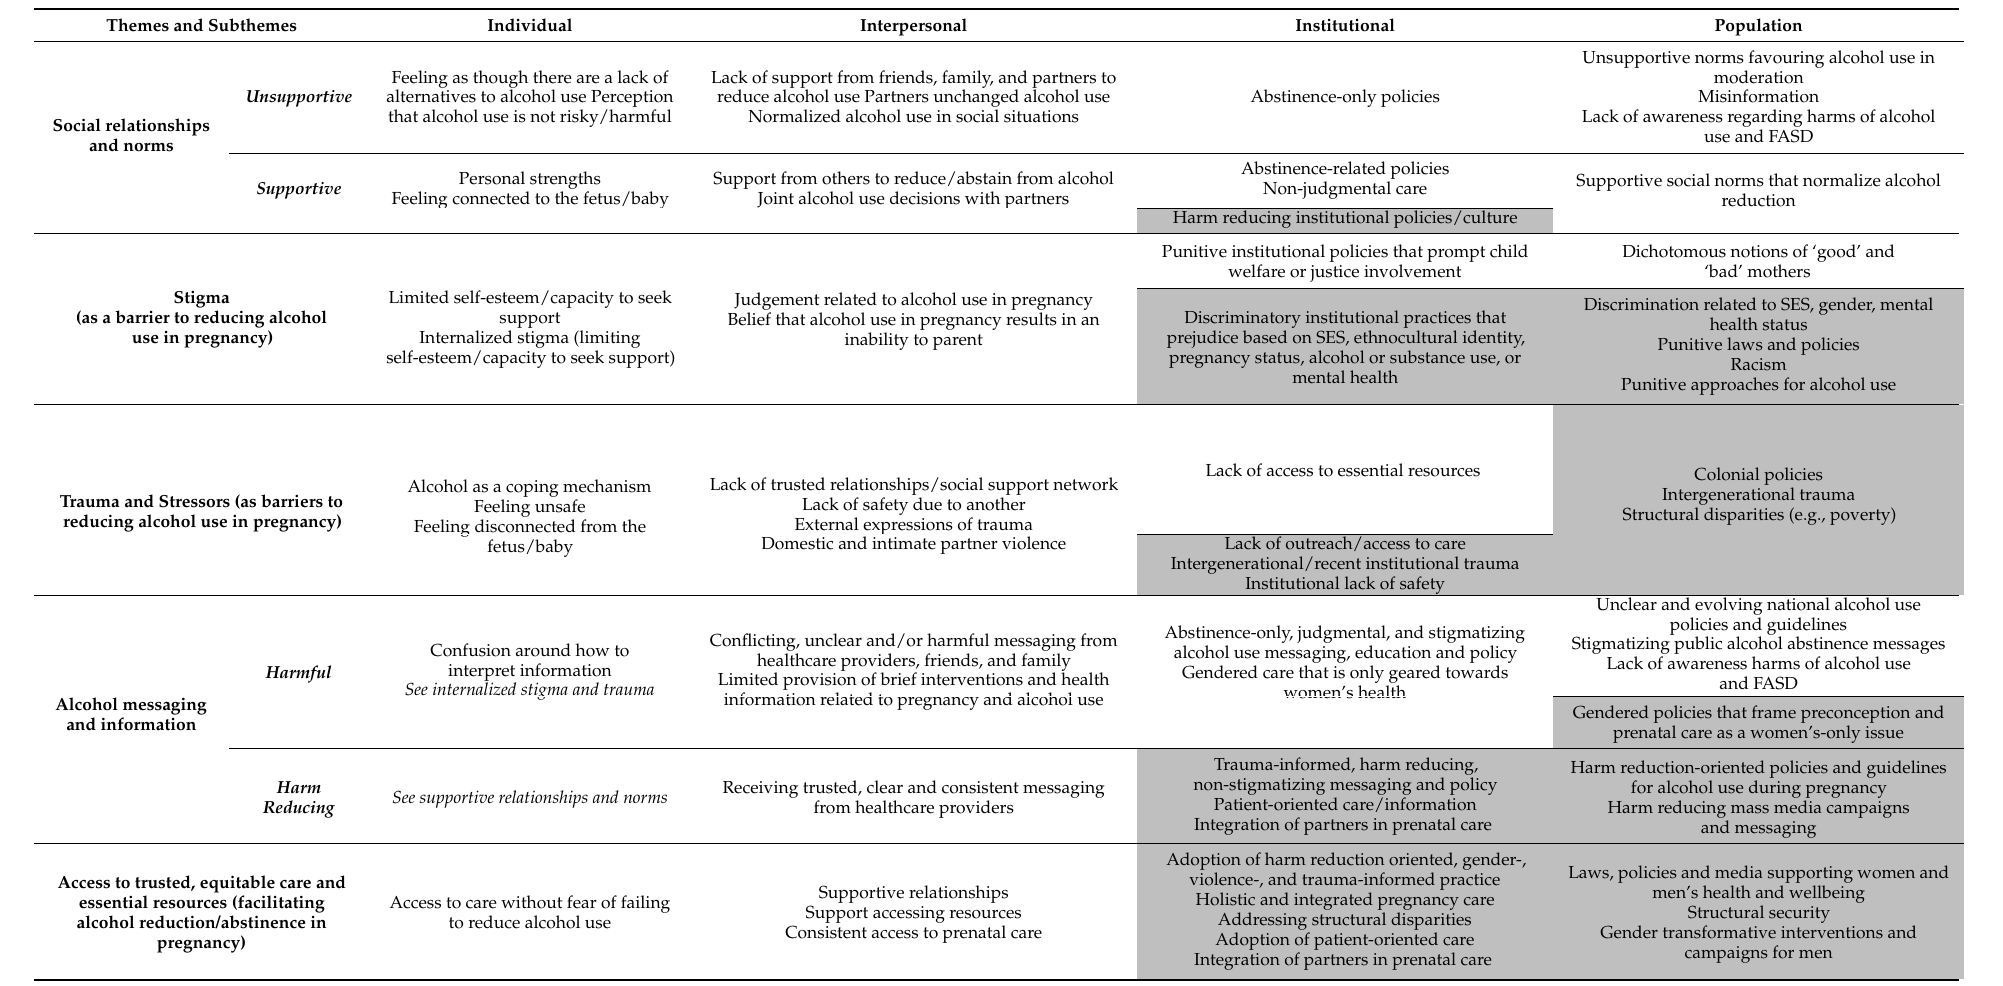
Table 3. Overview of the Findings and Gaps in the Literature Across Analytical Themes and Subthemes Related to Barriers and Facilitators to Alcohol Use in Pregnancy. Themes and